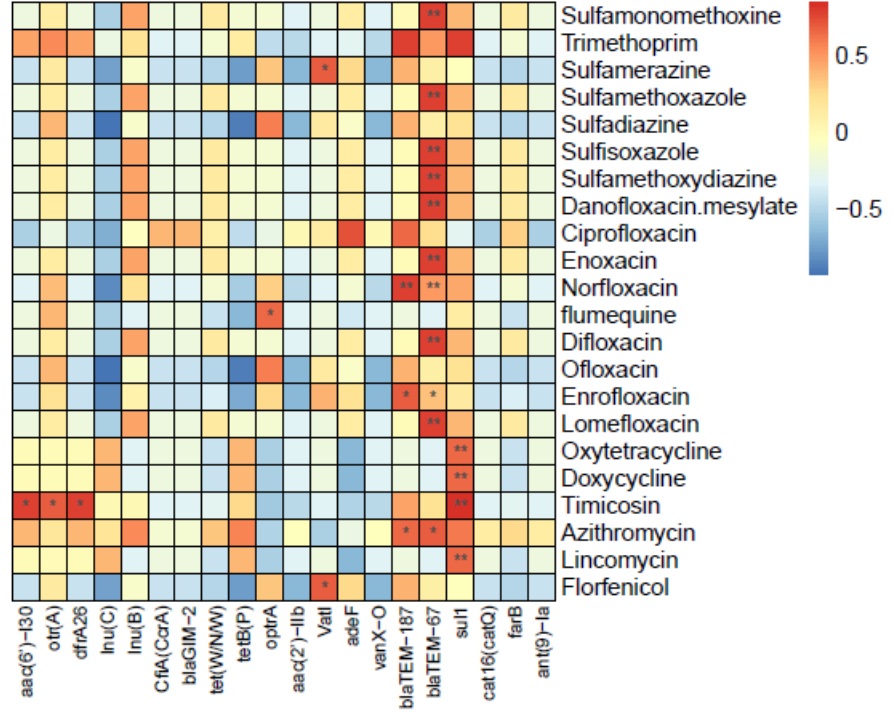
Figure 7. Heatmap of relative abundance of ARGs with antibiotics. *: significant difference, p < 0.05; **: highly significant difference, p < 0.01.